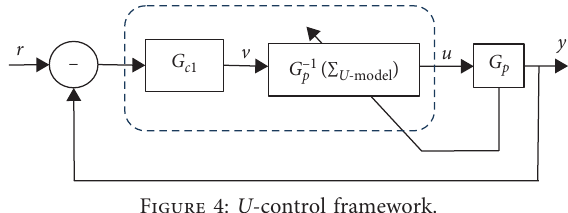
Figure 4: U -control framework.